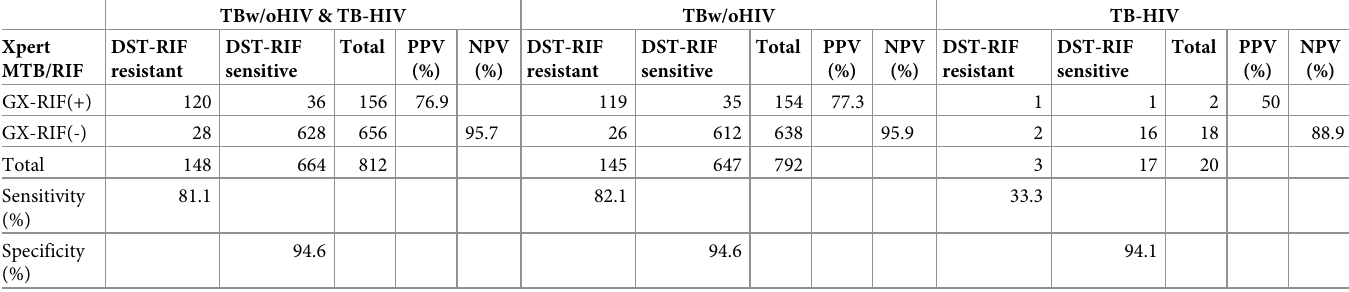
Table 4. Performance characteristics of the GeneXpert assay compared to drug susceptibility testing for rifampicin (RIF).